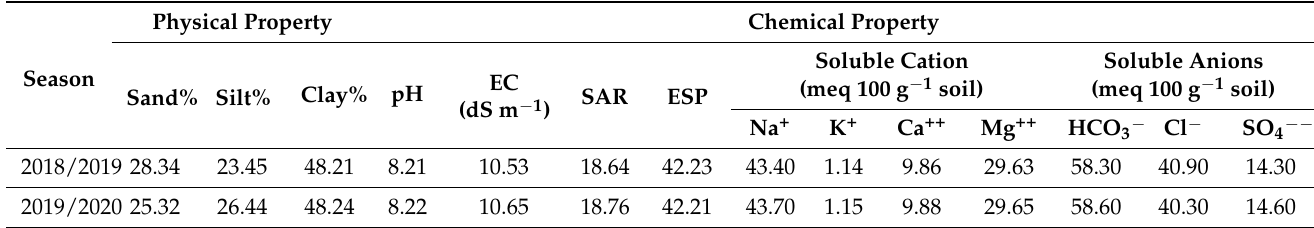
Table 1, according to US Soil Taxonomy (Soil Survey Staff 1999) [32]. Average monthly climatic data for the location during barley growing seasons of 2018/2019 and 2019/2020 was illustrated in Table 2. Table 1. The physical and chemical properties for the soil of study site.